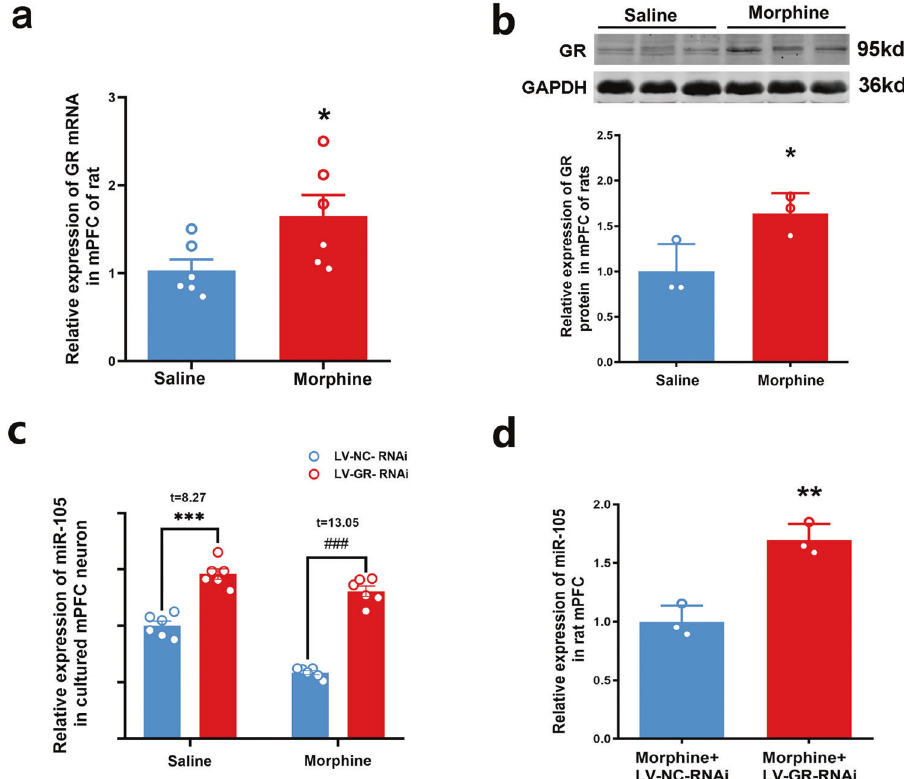
Fig. 3 The expression of GR after chronic morphine treatment and its role on miR-105 expression. a GR mRNA level in rat mPFC in morphine and saline groups ( n = 6 in each group, two-tailed t -test, * P = 0.0442). b GR protein level in rat mPFC in morphine and saline groups ( n = 3 in each group, two-tailed t -test, * P = 0.0419). c The levels of miR-105 of primary cultured mPFC neurons treated by chronic morphine and LV-NC-RNAi or LV-GR-RNAi ( n = 6 in each group, two-way ANOVA, F (1,20) = 11.43, P = 0.003. Bonferroni ’ s post-tests: *** P < 0.0001, t = 8.270, saline + LV-GR-RNAi group vs saline + LV-NC-RNAi group; ### P < 0.0001, t = 13.050, morphine + LV-GR-RNAi group vs morphine + LV-NC-RNAi group). d The miR-105 levels in rat mPFC of morphine + LV-GR-RNAi group and morphine + LV-NC-RNAi group ( n = 3 in each group, unpaired two-tailed Student ’ s t -test, t = 6.185, * * P = 0.0035). Data are presented as mean ±